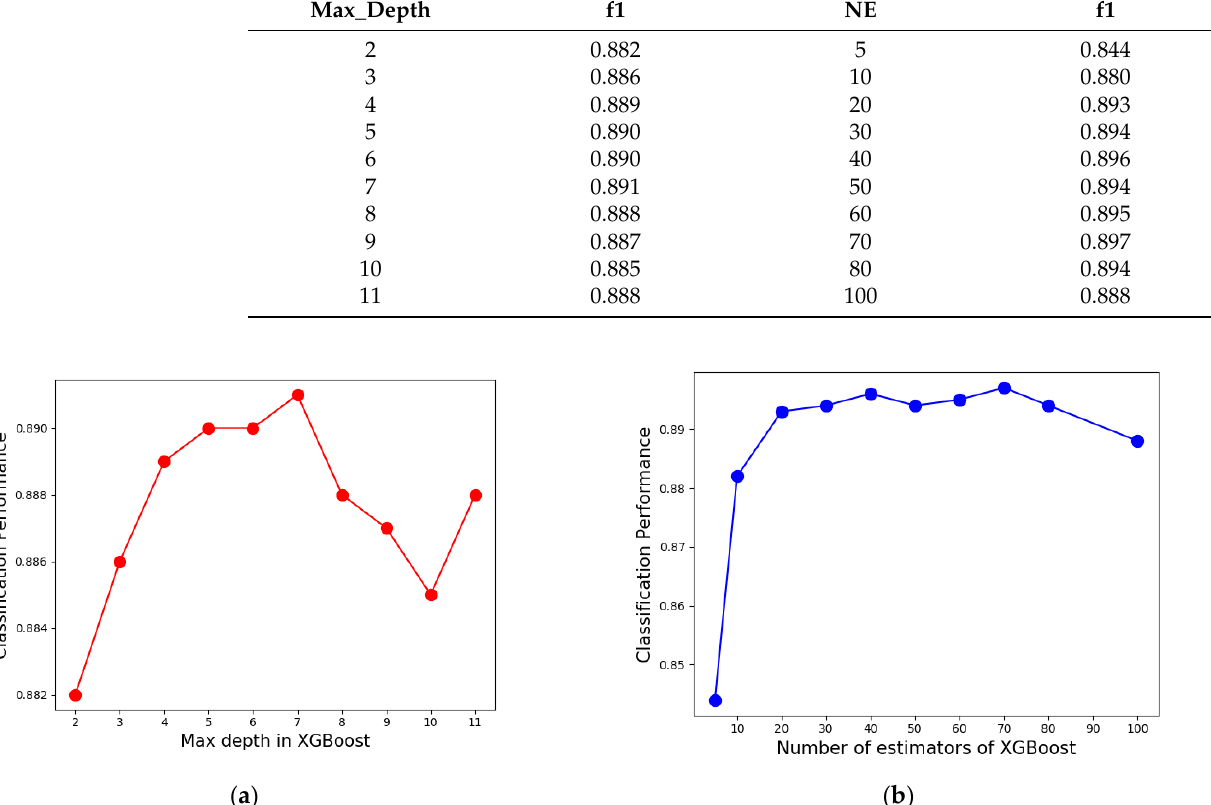
Table 7. XGBoost performance under different parameters.